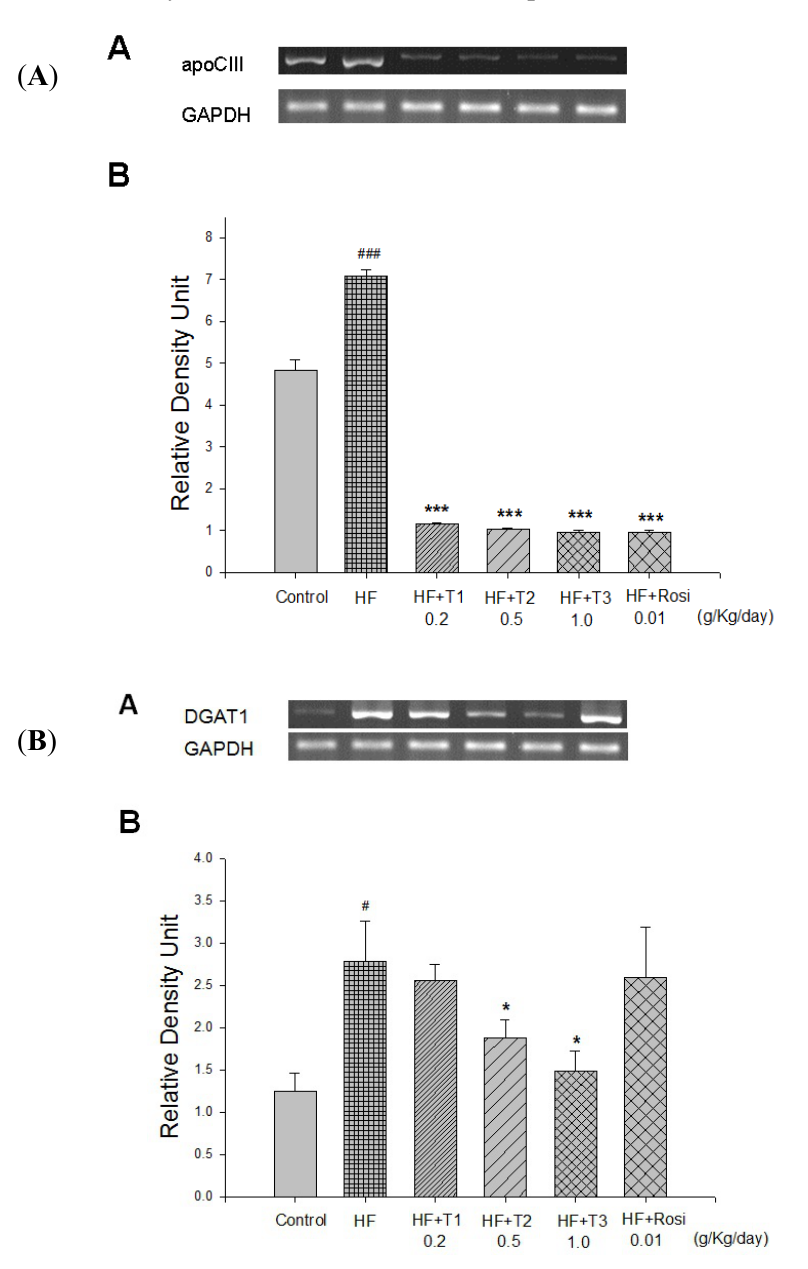
Figure 4. Semiquantative RT-PCR analysis for ( A ) apo C-III, (B) DGAT1, ( C ) DGAT2, ( D ) PEPCK, ( E ) 11 β -HSD1 and ( F ) ATGL mRNA expression in liver tissue; ( G ) leptin, and ( H ) 11 β -HSD1 mRNA expression in adipose tissue of the mice by oral gavage cell suspension culture of Eriobotrya japonica for 4 weeks. All values are means  S.E. (n = 9). # p < 0.05, ## p < 0.01, ### p < 0.001 compared with the control (CON) group; * p < 0.05, ** p < 0.01, *** p < 0.001 compared with the high-fat + vehicle (distilled water) (HF) group. Total RNA (1 μ g) isolated from tissue was reverse transcripted by MMLV-RT, 10 μ L of RT products was used as templates for PCR. Signals were quantitated by image analysis; each value was normalized by GAPDH. T1, T2, T3, cell suspension culture of Eriobotrya japonica